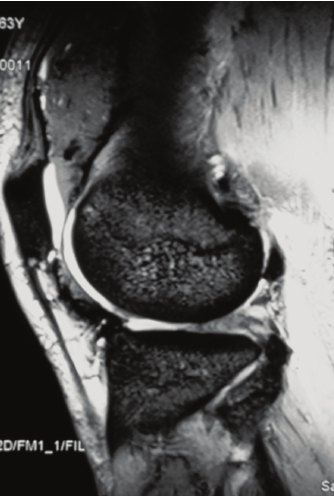
Figure 2: MRI of Case 1 (T2 weighted image). The posterior portion of the lateral meniscus is